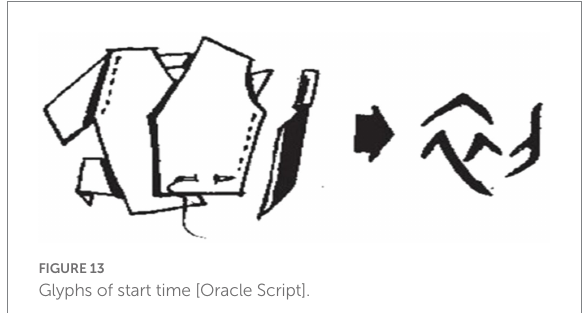
FIGURE 13 Glyphs of start time [Oracle Script].